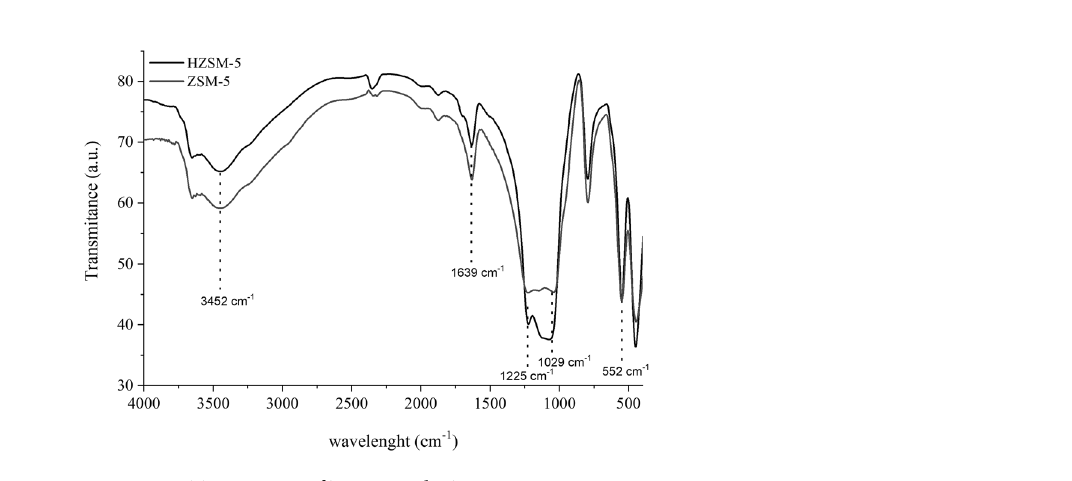
Figure 4. FT-IR spectra of ZSM-5 and